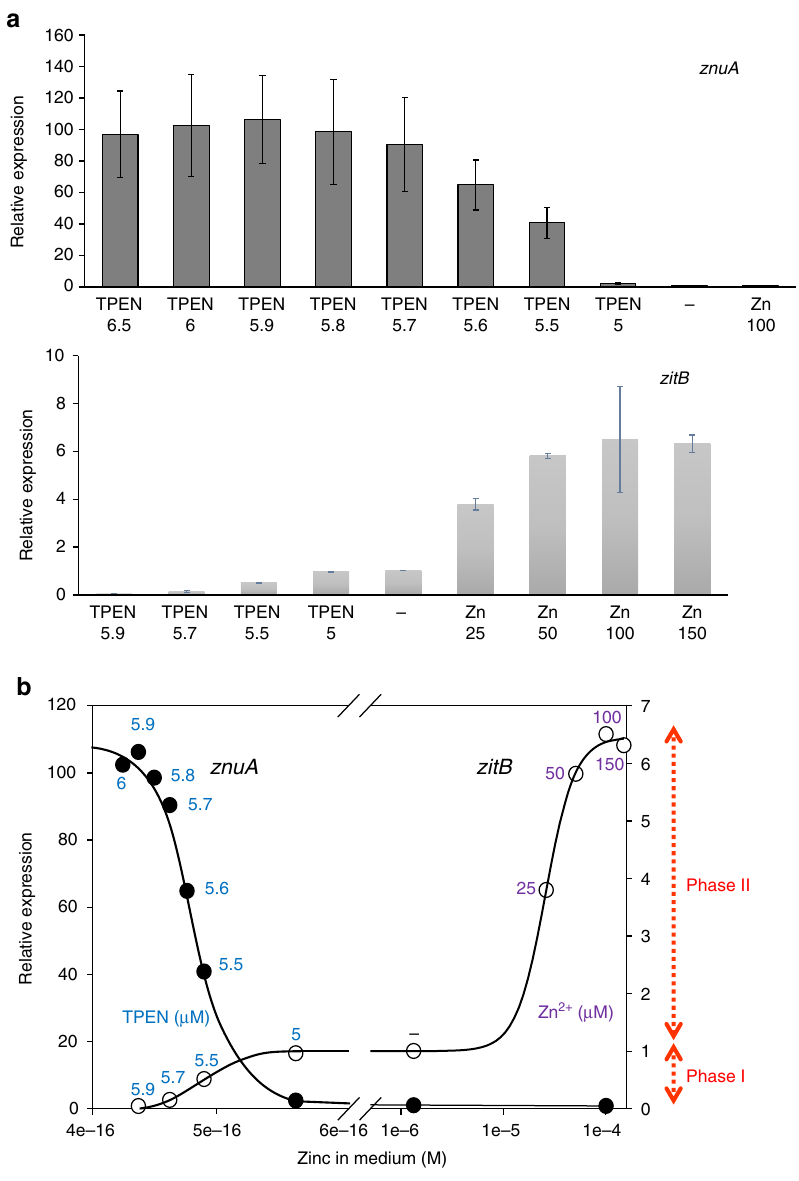
Figure 3 | Zinc-responsive expression of the zitB gene in comparison with the zinc uptake ( znuA ) gene. ( a ) S1 mapping analysis of znuA and zitB transcripts under TPEN or zinc-treated conditions. The wild-type cells grown in YEME medium to exponential growth (OD 600 of 0.4 to B 0.5) were treated for 30min with TPEN (5.0–6.5 m M as indicated), ZnSO 4 (25–150 m M as indicated) or none, before cell harvest. Quantifications of S1 mapping results were done from 11 independent experiments for znuA , and 3–6 experiments for zitB transcript analysis. The relative expression values with s.d.’s were presented, taking the untreated sample values as 1.0. The P values for all the measurements were o 0.001 by Student’s t -test, except the zitB value for 5 m M TPEN treatment ( P 4 0.8). ( b ) The relative expression levels of znuA and zitB mRNAs were plotted against the concentrations of zinc in the medium. The maximally expressed levels were drawn as equal heights in the y axis for both znuA (solid circle; left axis) and zitB (open circle; right axis). The concentration of zinc in the TPEN-treated samples was calculated from the concentrations of treated TEPN ( m M; in blue number). The added amount of Zn ( m M) was indicated in purple. The amount of zinc in non-treated YEME medium ( (cid:2) ) estimated by ICP-MS was 1.33 m M. The biphasic induction of the zitB gene was labeled as phase I (at sub-femtomolar zinc) and phase II (at 4 micromolar